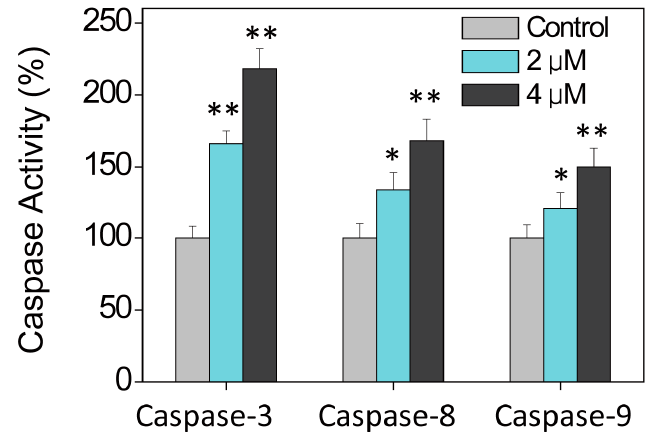
Figure 6. Caspase activities in HCC cells following Ru2 exposure as evaluated via a specific fluorogenic substrate. * p < 0.05 and ** p < 0.01 compared with the control. Cells were treated with Ru complexes for 24 h.